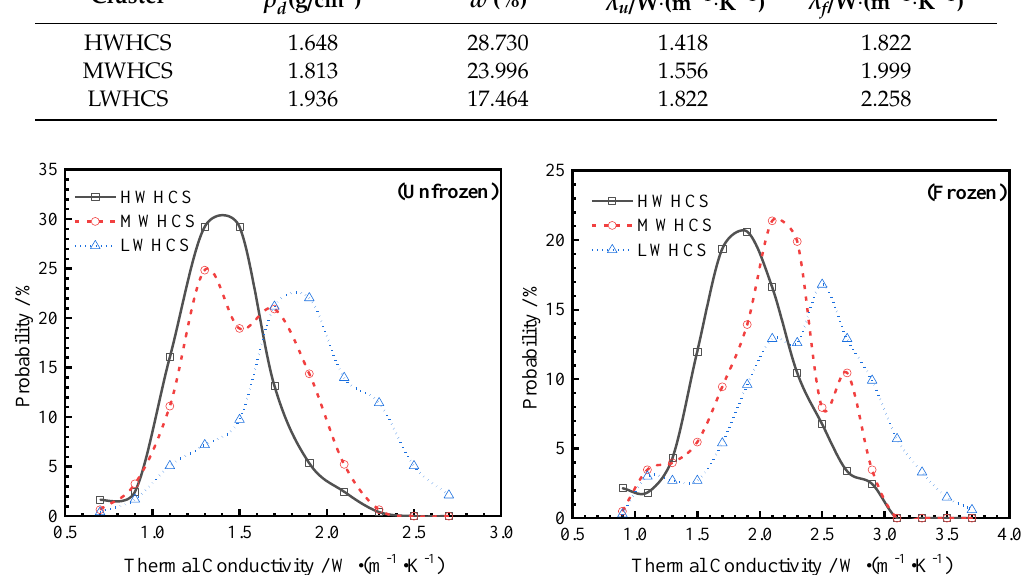
Figure 7. Probability distribution of thermal conductivity of three soil clusters.